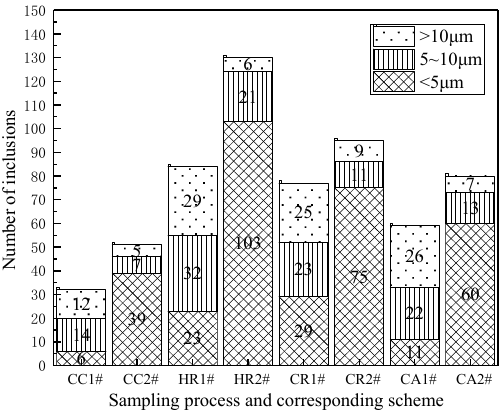
Figure 3. The statistics of inclusion size and quantity in each process.